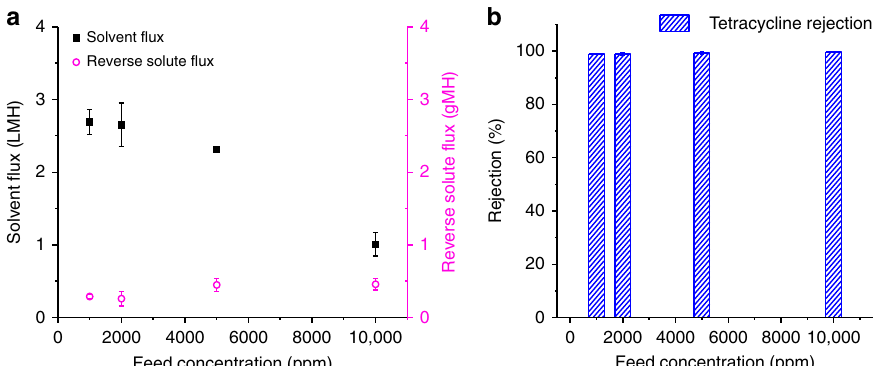
Fig. 3 Assessment of the effect of the feed solution concentration. a Solvent fl ux and reverse solute fl ux as a function of tetracycline concentration. b Tetracycline rejections under different tetracycline concentrations. The draw solution is 2 M LiCl in ethanol and the operation mode is the FO mode. The error bar represented the standard deviation from at least three independent OSFO tests with different membrane coupons, and the interfacial polymerization was conducted separately for each membrane coupon. Our results indicate that the OSFO process is able to concentrate a pharmaceutical product up to 10000 ppm without sacri fi cing the rejection